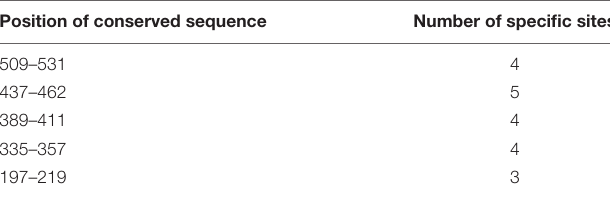
TABLE 6 | The relatively conserved regions of the COI barcode of Heosemys grandis . Position of conserved